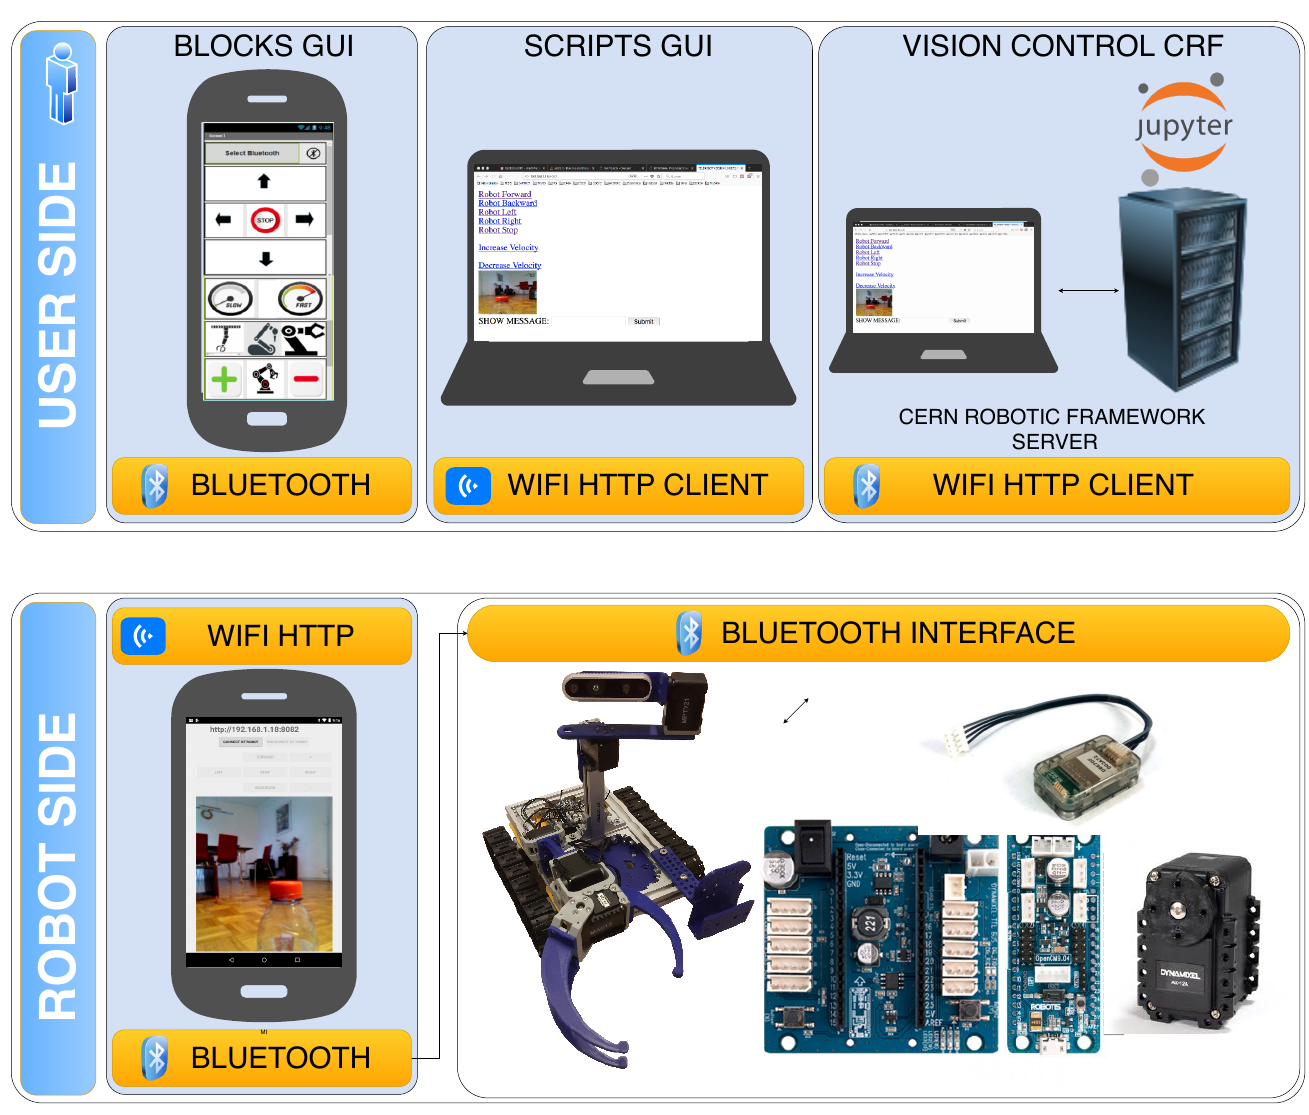
Figure 23 represented the blocks that can be developed by the students as a learning path, including the Blocks GUI, Scripts GUI, Vision Control CERN Robotic Framework, and the robot-side on-board the Android HTTP controller. These blocks have been explained in detail in the previous section.